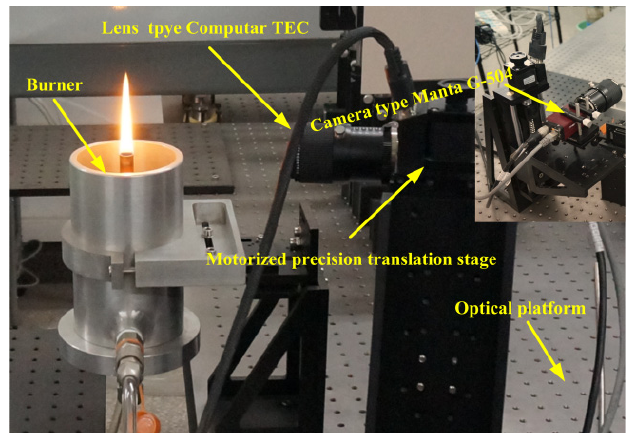
Figure 6. Photo of the digital flame images acquisition system. Table 1. Experimental conditions.